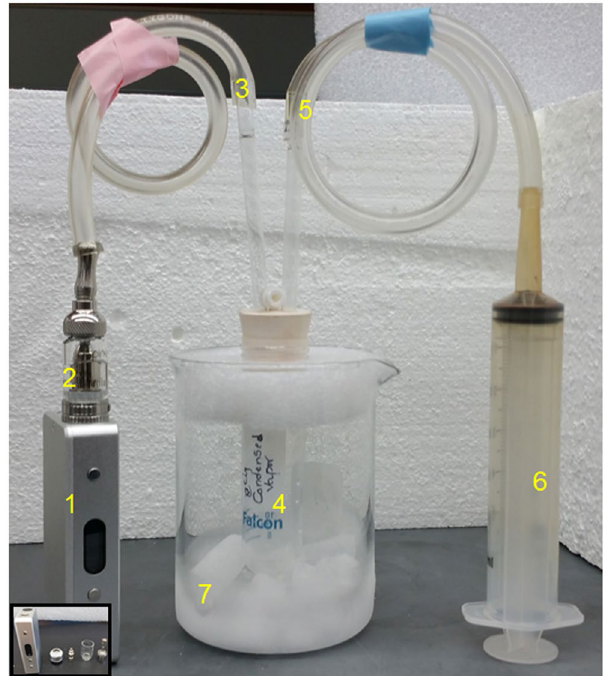
Figure 1. Generation of eCig vapor condensate. eCig liquid was added to the tank system atomizer (1 & inset) and connected to the electronic smoking device (2). Using a custom assembly (3 & 5), 40 ml eCig vapor “puffs” were drawn into a test tube using a 60 ml syringe (4), with each puff lasting for 4 seconds. Vapor spontaneously condensed in the tube (6), which was chilled above a liquid nitrogen/dry ice bath